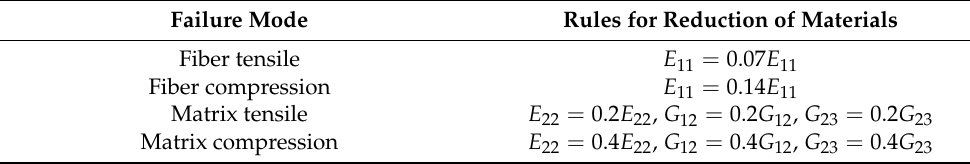
Table 3. Degradation modes of material